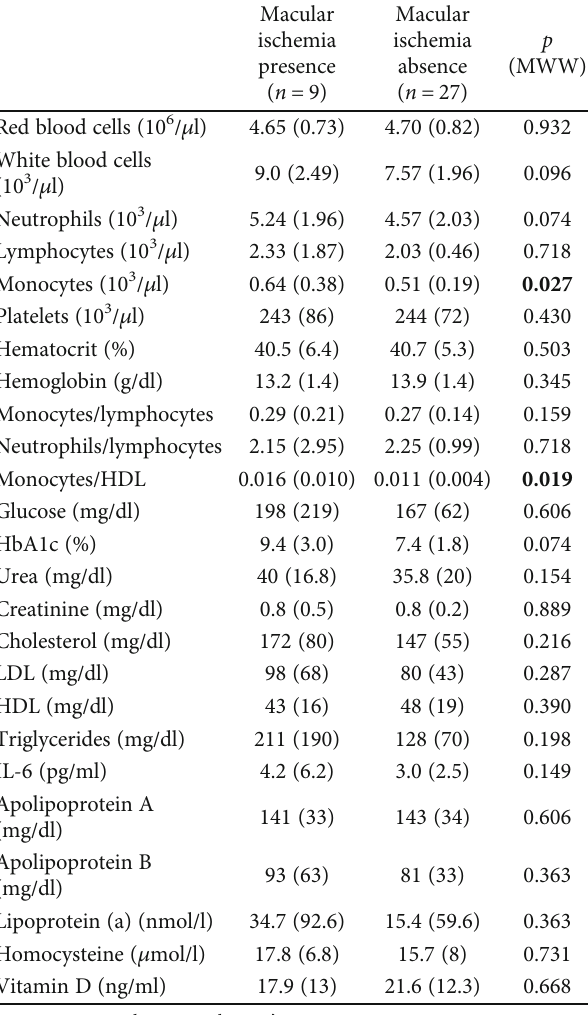
Table 3: Association between laboratory variables and ellipsoid zone condition on optical coherence tomography. Laboratory variables are summarized as median (IQR: interquartile